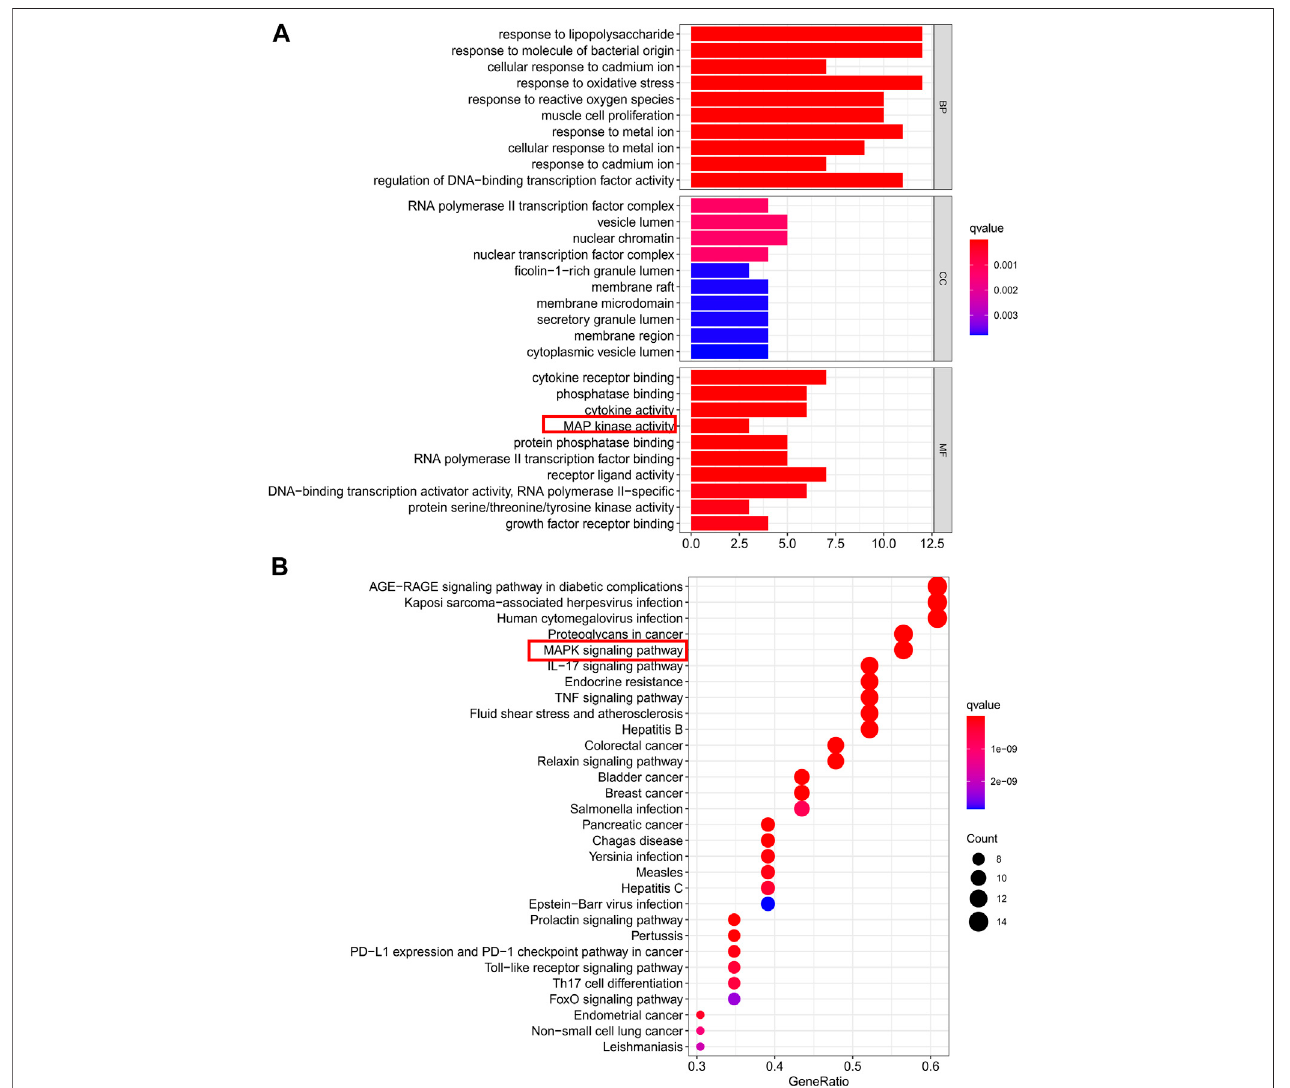
FIGURE 3 | Gene ontology terms and KEGG pathway enrichment of core candidate targets of CDG against PD. (A) GO of core candidate targets of CDG against PD.Thetop-10termsineachGOcategorywith p AdjustValue < 0.05wereselected.BP,biologicalprocess;CC,cellularcomponents;MF,molecularfunction. (B) KEGG pathway enrichment of core candidate targets of CDG against PD. The top-30 pathways that had signi fi cant changes of P Adjust Value < 0.05 were identi fi ed.